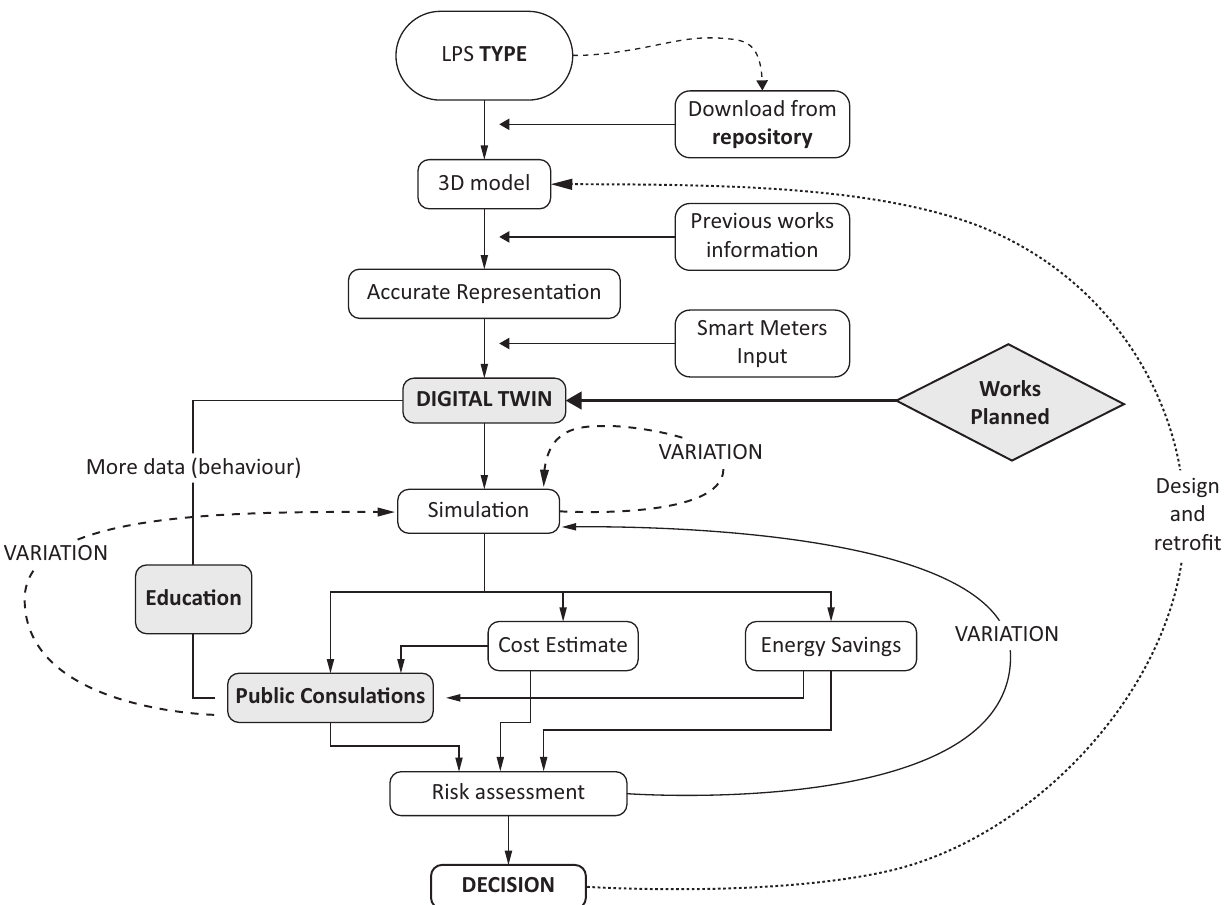
Figure 1. The DT process for LPS retrofit projects showing the directions of the information feed. for wide consultation and information of all stakehold‐ ers allows for better decisions with lesser risks